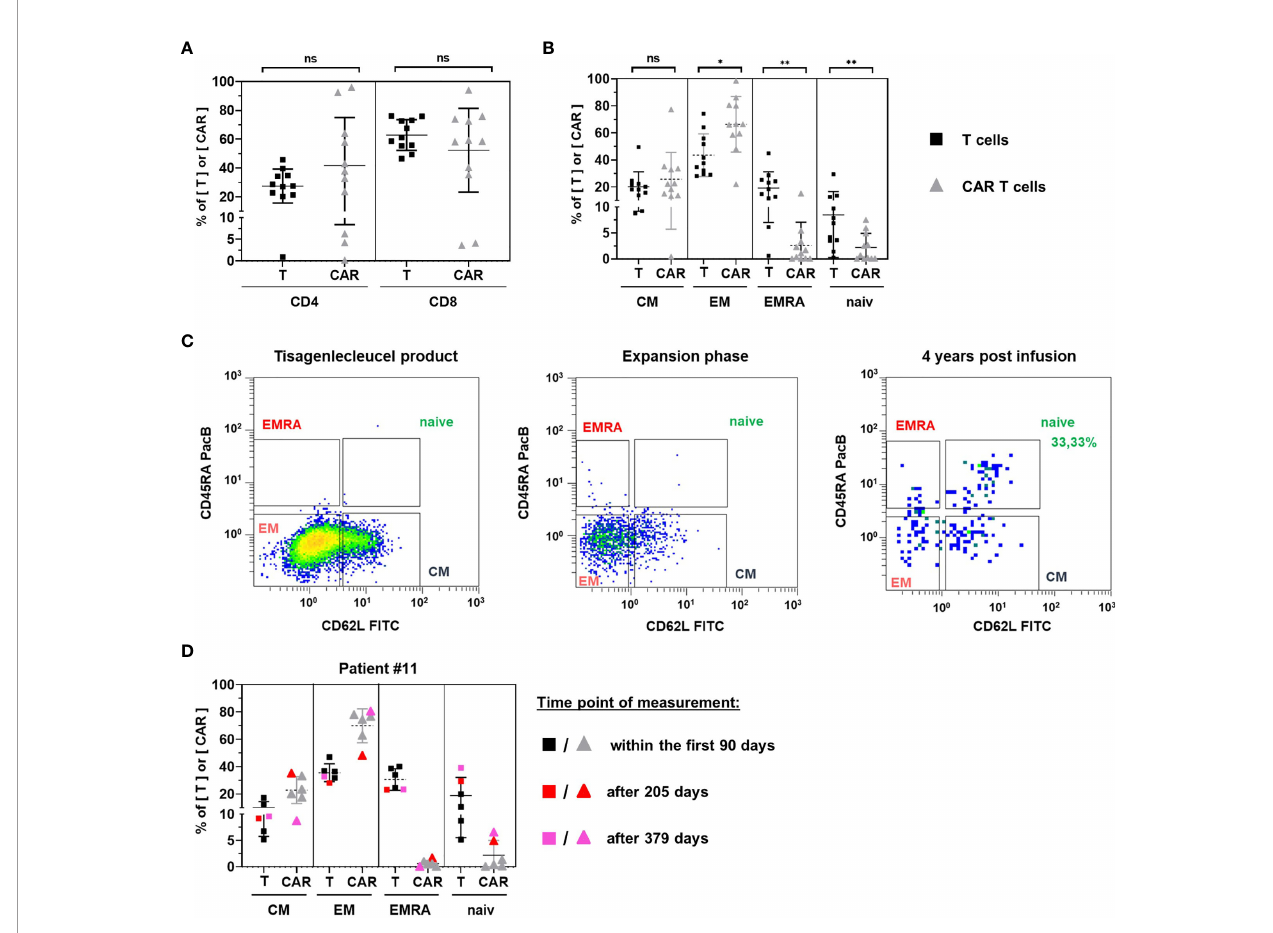
FIGURE 6 | Phenotypic analysis. CD4 and CD8 positive subsets (A) and subsets positive for central memory, effector memory, EMRA, and naïve marker signatures (B) were compared between T cells (black squares) and CAR T cells (grey triangles) for 11 patients in their initial expansion phase. (C) Representative gating of naïve CAR T cells in subpopulation analyses of tisagenlecleucel product cells (left) and patient samples during the period of exponential expansion (middle) as compared to one patient ’ s sample 4 years after CAR T cell infusion (right). (D) subpopulation analysis was performed four times within the fi rst 90 days (uncolored symbols) and once 205 days (red symbols) and 379 days (pink symbols) post CAR T cell infusion of patient #11. Horizontal bars represent the mean. Vertical error bars indicate the standard deviation. ns, not signi fi cant; *p < 0.05; **p <